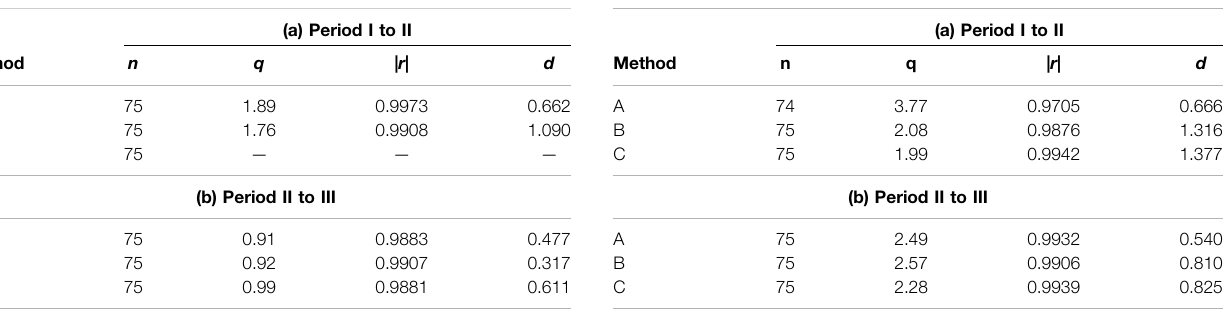
TABLE7| Comparisonofoptimal fi ttingparametersintherankdependenceofthe intersecting angle of the monthly temperatures on the Japanese stations. (a) FromPeriodI(from1931to1960)toPeriodII(from1951to1980);(b)FromPeriod II (from 1951 to 1980) to Period III (from 1981 to 2010).